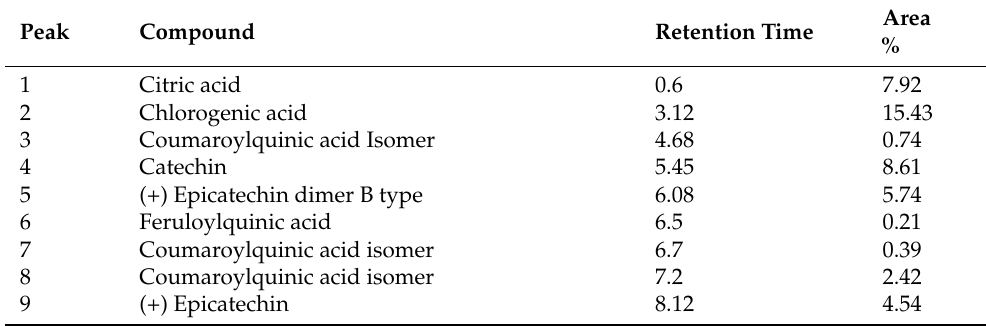
Table 4. Retention time (min) and peak area, expressed as percentage of total area of the identified compounds in P. domestica subsp. syriaca fruit pulp